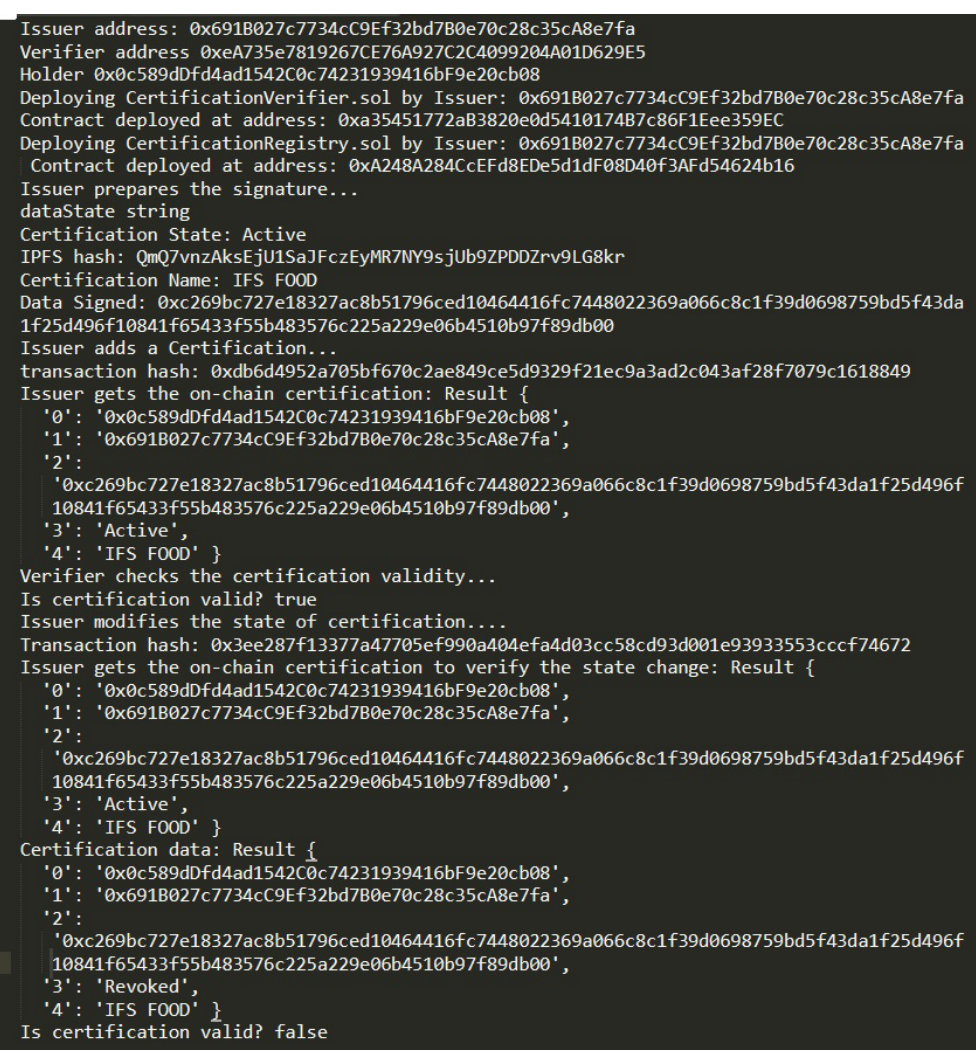
Figure 6. Outputs of nodejs